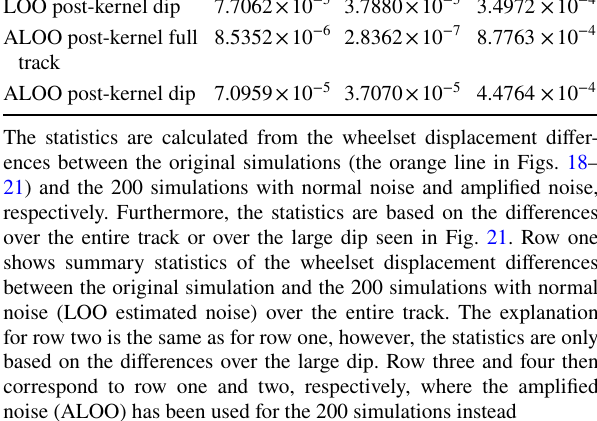
Table 6 Summary statistics quantifying the influence of the kernel errors on the wheelset dynamics